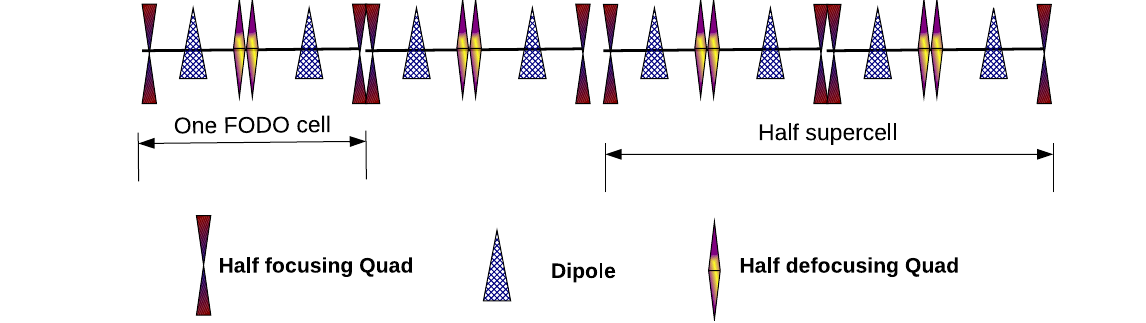
FIG. 1. Sketch of one super period of the optics under study.